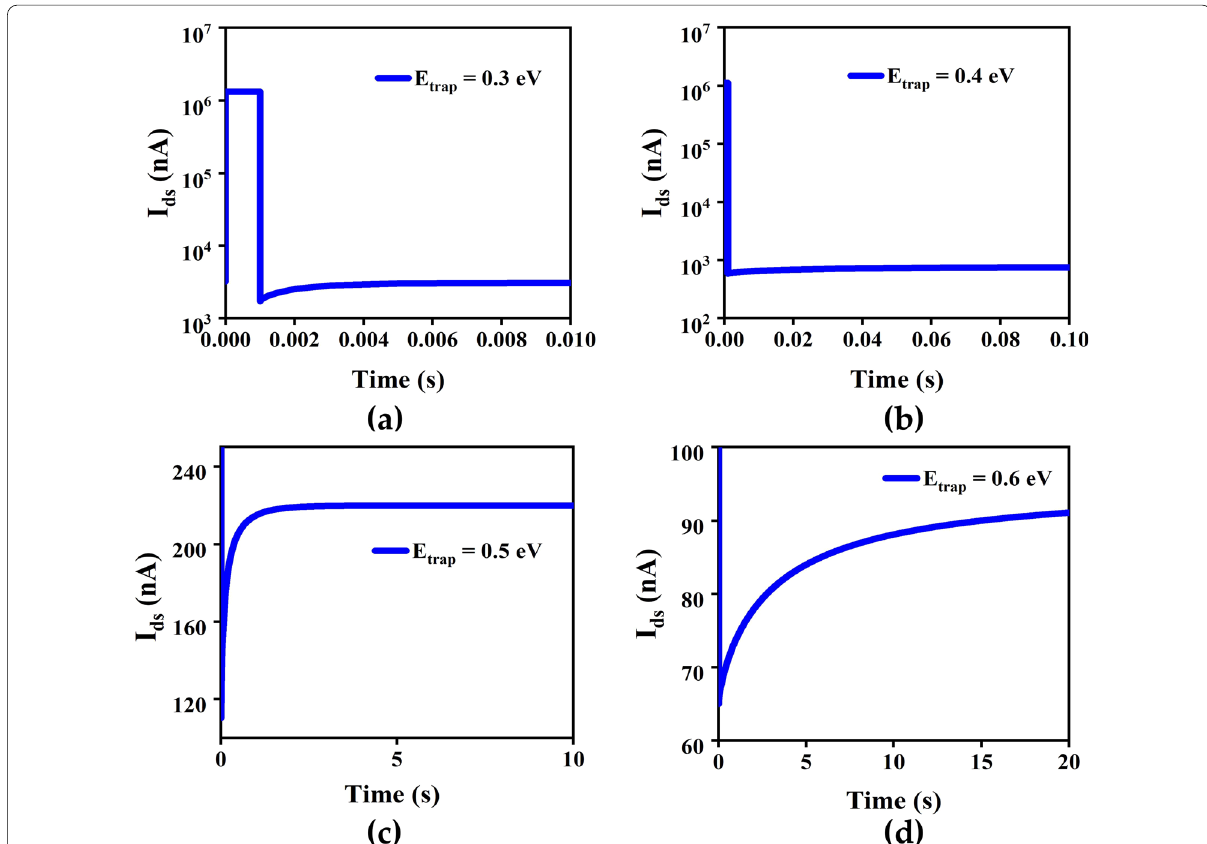
Fig. 4 The excitatory PSC when the trap levels are set at different depth (0.3 eV, 0.4 eV, 0.5 eV, 0.6 eV) at V ds gate electric pulses are set at 2 V and 1 ms,